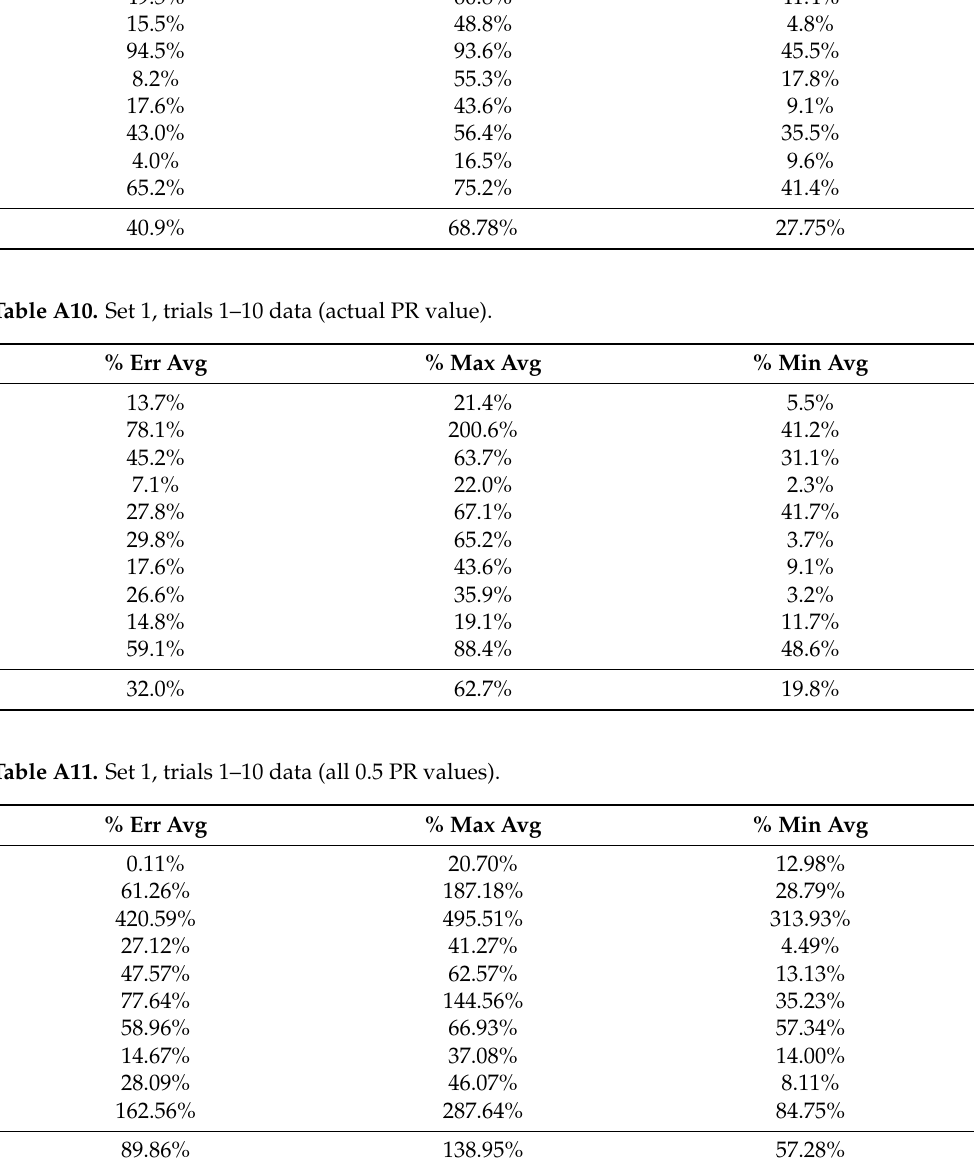
err divided by Table A1’s average error row. Likewise, % max avg and % min avg are the results of values from Table A5 being divided by corresponding values from Table A1.